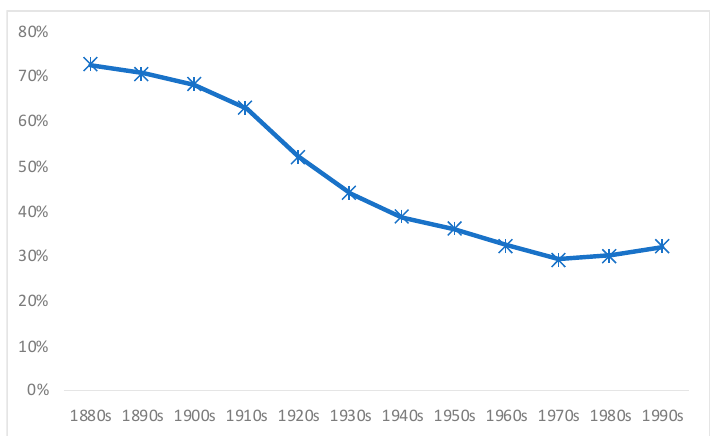
Figure 7. Chile’s poverty rates (share of the population). Source: Own elaboration from Prados de La Escosura [84].